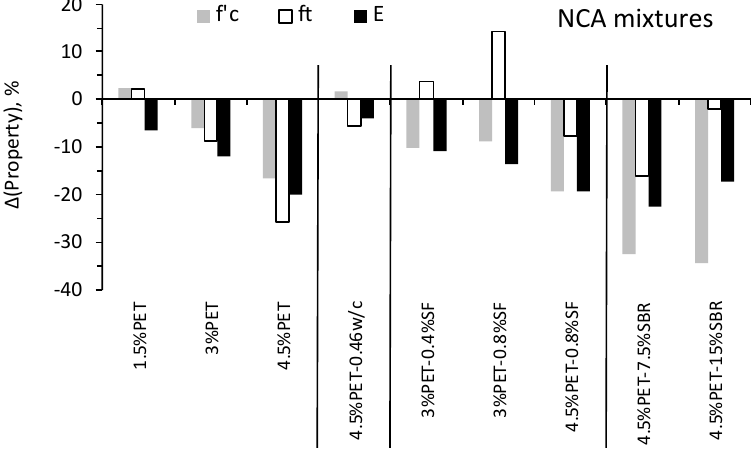
Figure 3. Effect of PET additions on Δ (f’c, ft, and E) for NCA concrete mixtures.